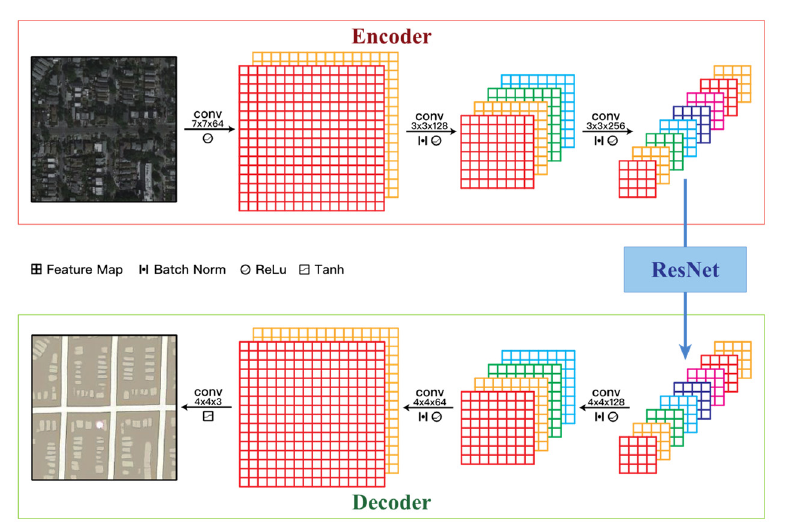
Figure 2. Structure of the mapping network.